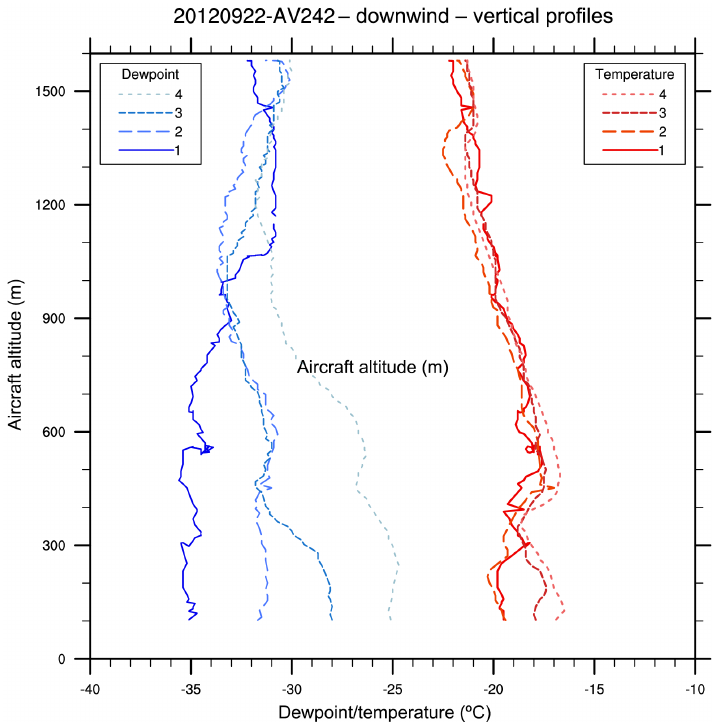
Figure 5. Sample of profile data – temperature and dew point at four vertical ascent profiles from 22 September 2012 AV 242. The profiles start 5km from the coast and continue